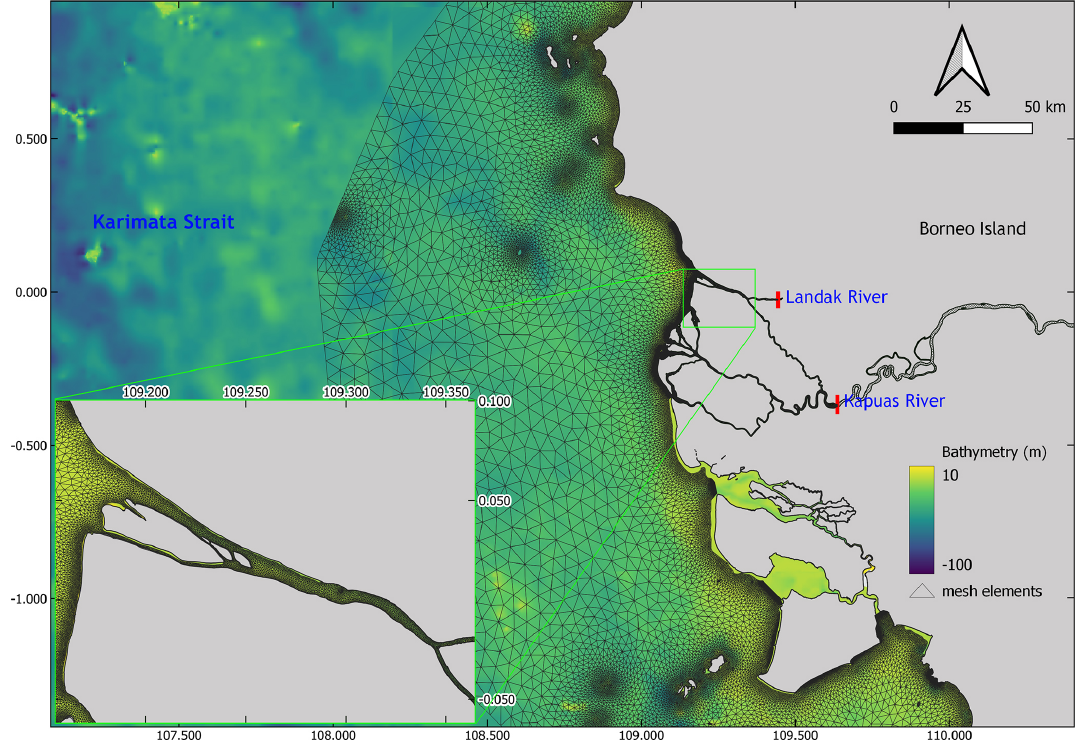
Figure 3. The hydrodynamic model domain is discretized with an unstructured mesh with its resolution set to 50m along the riverbanks, 400m along the coast near the estuary, 1km over the rest of the coastline, and 5km offshore. The bathymetry of the model domain ranges from ∼ 100m depth offshore to 1m in the river